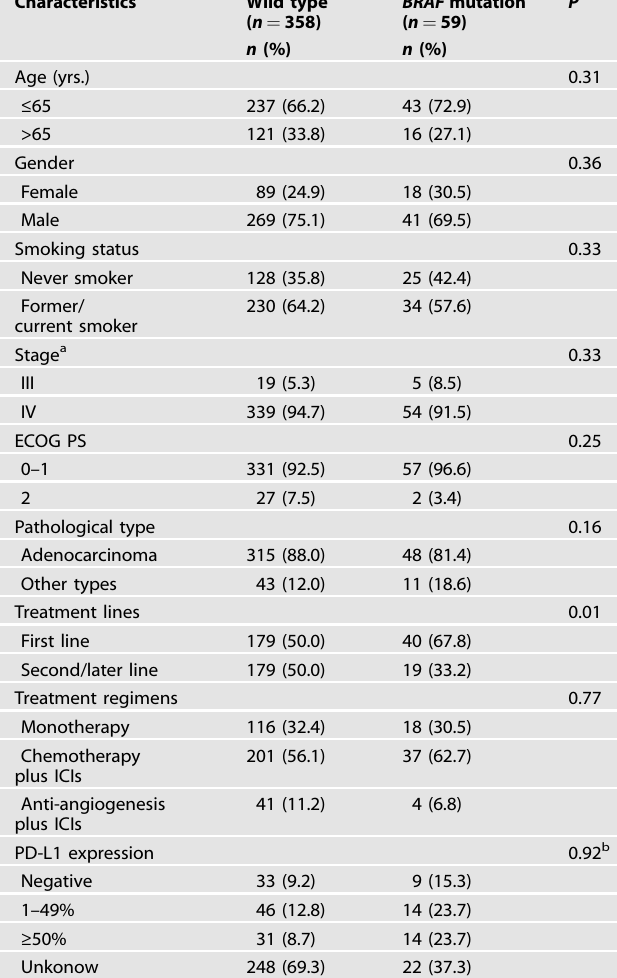
Table 2. Association of demographics and clinicopathological characteristics with BRAF mutation status in Cohort B.